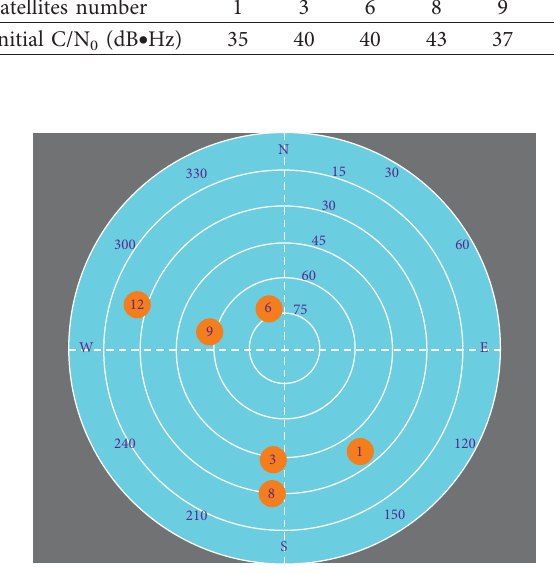
Figure 5: The sky plot of the